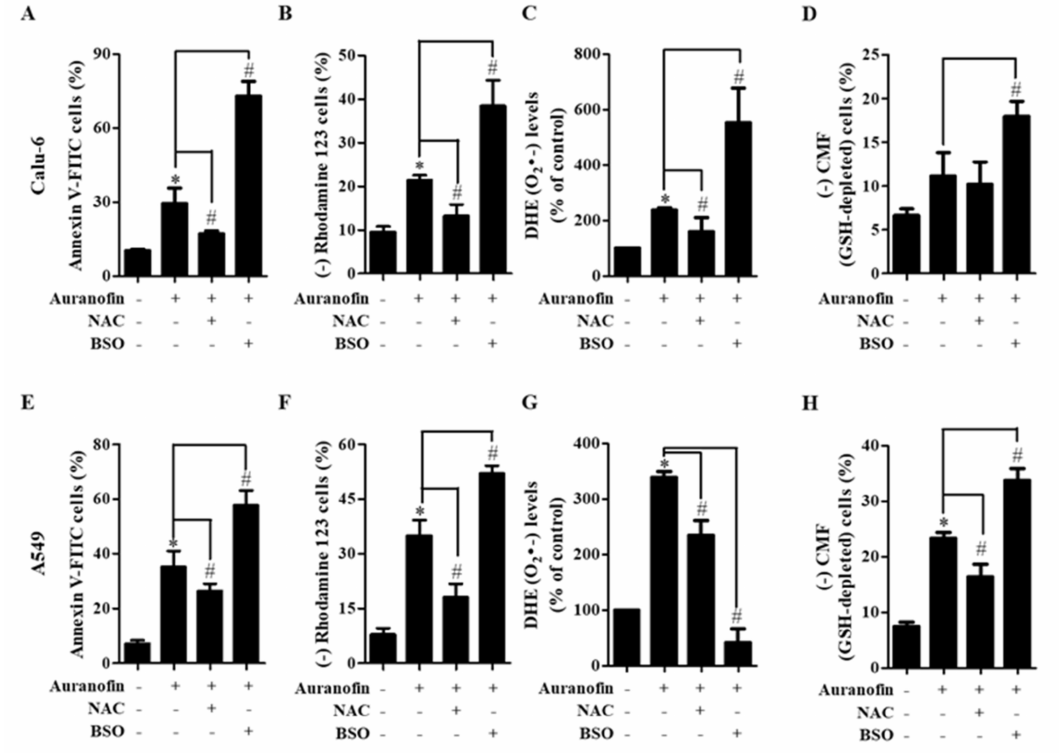
Figure 5. Effects of NAC and BSO on cell death, MMP ( ∆Ψ m), DHE (O 2 •− ) levels, and GSH depletion in auranofin-treated Calu-6 and A549 cells. Exponentially growing Calu-6 and A549 cells were incubated with 3 and 5 µ M auranofin for 24 h, respectively, following 1 h preincubation with 2 mM NAC or 10 µ M BSO. A, B, E and F: Graphs illustrate the percentages of annexin V-FITC-stained cells in Calu-6 cells ( A ) and A549 cells ( E ) and rhodamine 123-negative MMP ( ∆Ψ m) cells in Calu-6 cells ( B ) and A549 cells ( F ), respectively. ( C , G ): Graphs indicate DHE (O 2 •− ) levels (%) compared with control cells in Calu-6 cells ( C ) and A549 cells ( G ), respectively. ( D , H ): Graphs designate the percentages of negative CMF (GSH-depleted) cells in Calu-6 cells ( D ) and A549 cells ( H ). * p < 0.05 compared with auranofin-untreated control cells. # p < 0.05 compared with cells treated with auranofin